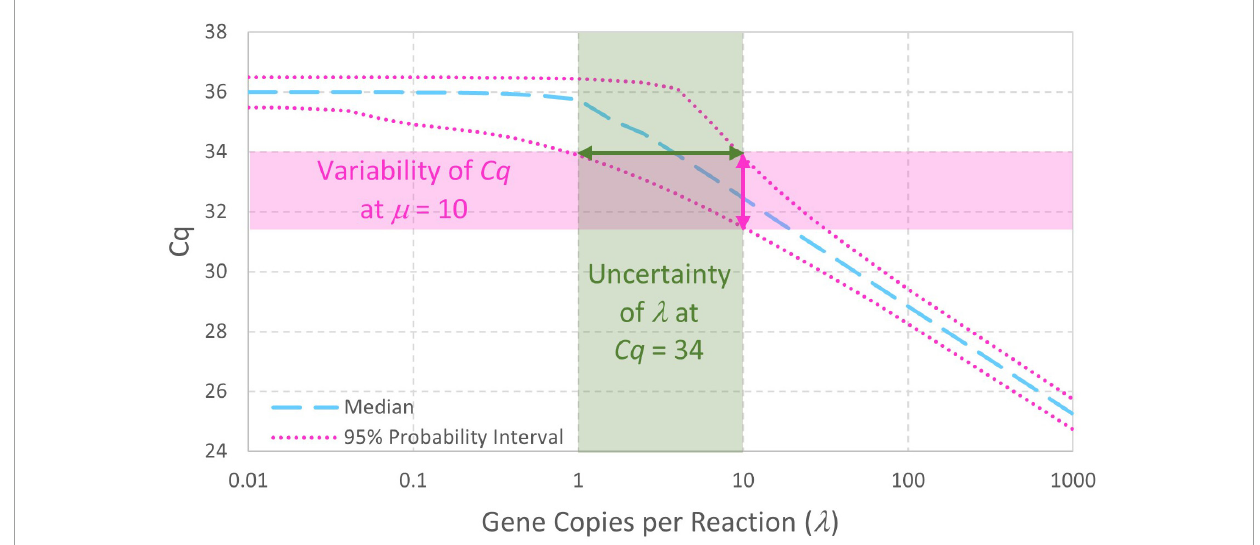
FIGURE3 Probability intervals describing variability in Cq as a function of gene copies per reaction also give a visual approximation to begin quantitatively understanding the uncertainty in qPCR-based concentration estimates. The displayed standard curve model includes Poisson-distributed reaction random sampling error and has intercept 36, amplification efficiency E = 0 . 9, and Cq residual standard deviation σ = 0 . 25.